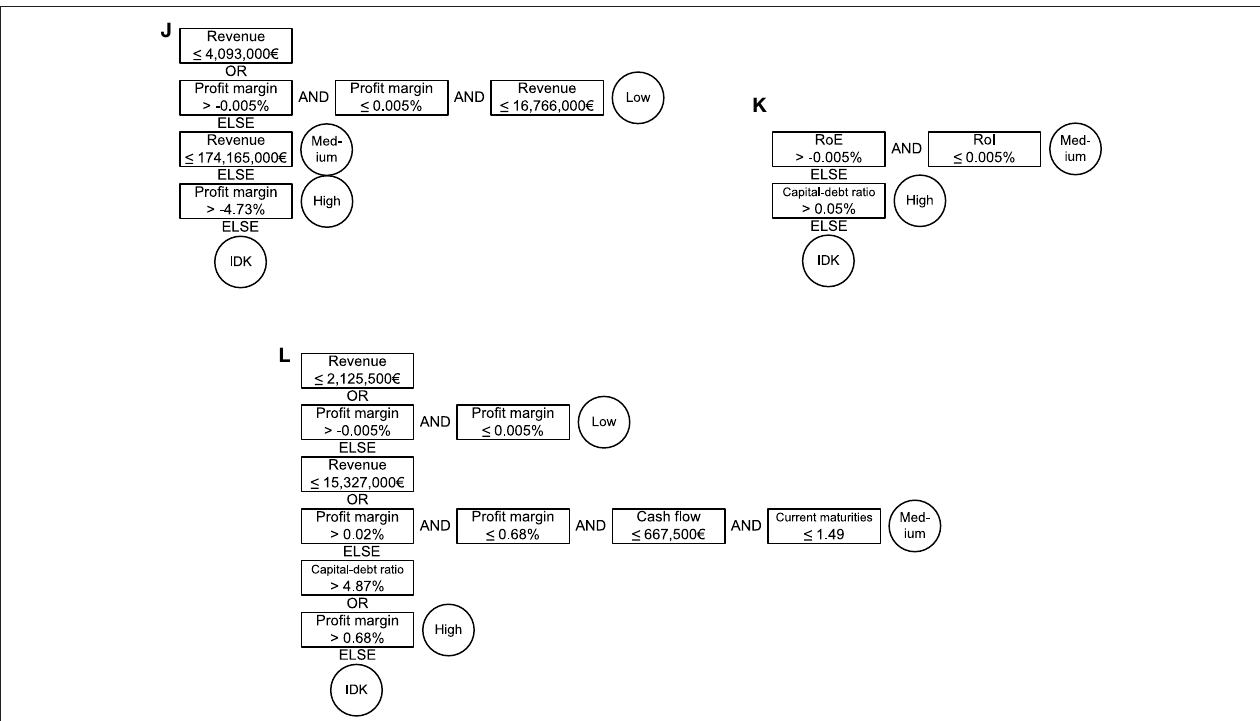
FIGURE 6 | Example models for Thresholder DNFs using IDK-classifications built on the three data sets. (J) Trade data set model. (K) Finance data set model. (L) Construction data set